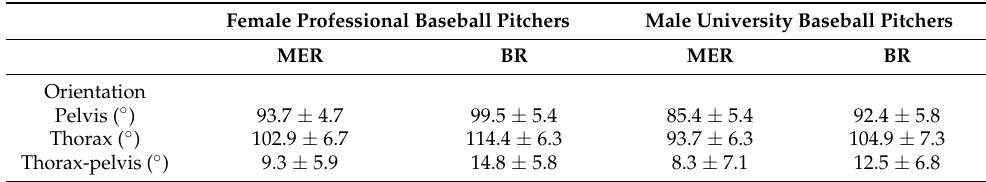
Table 3. Orientation of the pelvis and